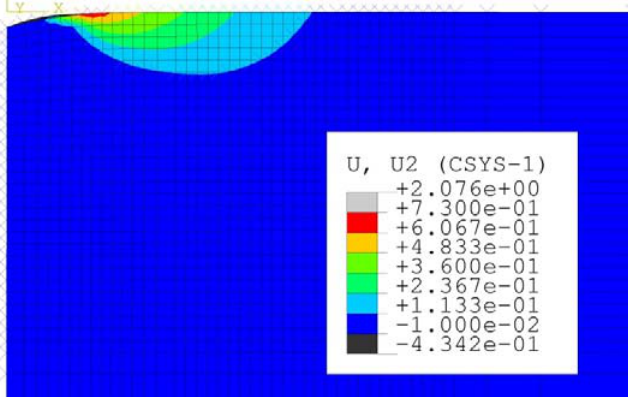
Figure 5: Contour map of the crack opening displacements of the half-penny shape fracture surface produced by indentation (simulation